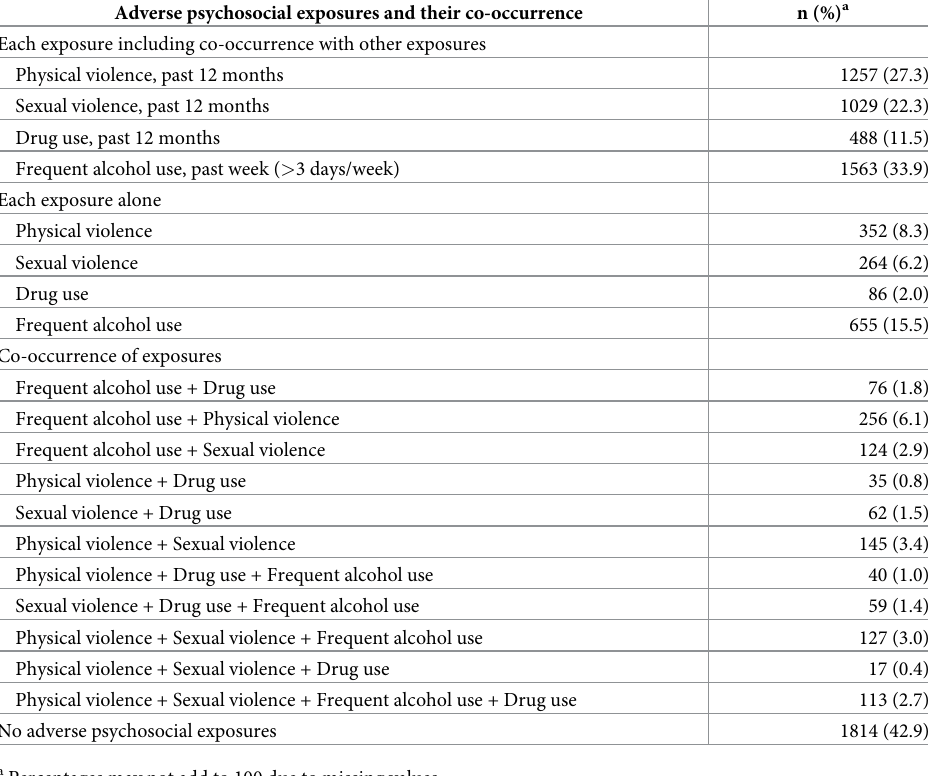
Table 3. Adverse psychosocial exposures among HIV-negative transgender women (N = 4,607): Physical violence, sexual violence, frequent alcohol use, drug use, and their co-occurrence. Adverse psychosocial exposures and their co-occurrence n (%) a Each exposure including co-occurrence with other exposures Physical violence, past 12 months 1257 (27.3) Sexual violence, past 12 months 1029 (22.3) Drug use, past 12 months 488 (11.5) Frequent alcohol use, past week ( > 3 days/week) 1563 (33.9) Each exposure alone Physical violence 352 (8.3) Sexual violence 264 (6.2) Drug use 86 (2.0) Frequent alcohol use 655 (15.5) Co-occurrence of exposures Frequent alcohol use + Drug use 76 (1.8) Frequent alcohol use + Physical violence 256 (6.1) Frequent alcohol use + Sexual violence 124 (2.9) Physical violence + Drug use 35 (0.8) Sexual violence + Drug use 62 (1.5) Physical violence + Sexual violence 145 (3.4) Physical violence + Drug use + Frequent alcohol use 40 (1.0) Sexual violence + Drug use + Frequent alcohol use 59 (1.4) Physical violence + Sexual violence + Frequent alcohol use 127 (3.0) Physical violence + Sexual violence + Drug use 17 (0.4) Physical violence + Sexual violence + Frequent alcohol use + Drug use 113 (2.7) No adverse psychosocial exposures 1814